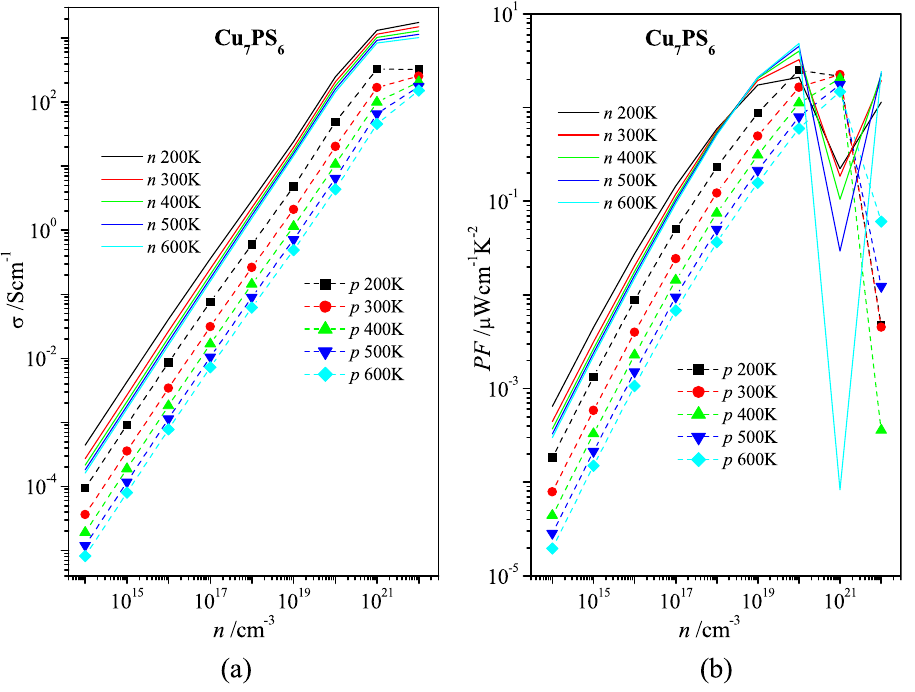
Figure 5. Dependences of ( a ) electric conductivity σ and ( b ) power factor PF on carrier concentration n for Cu